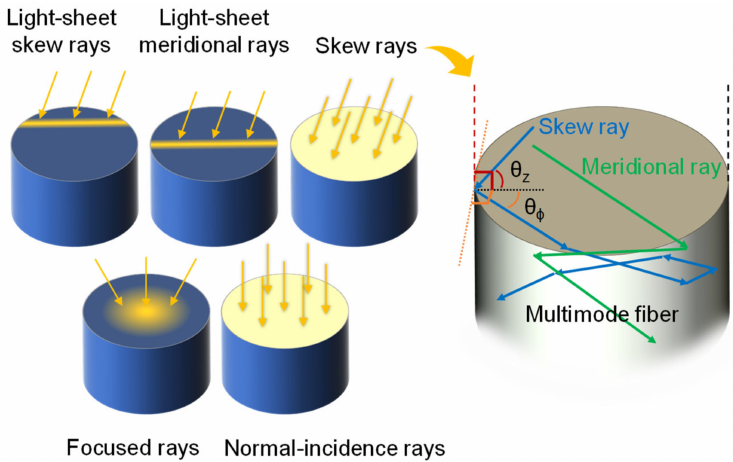
Figure 1. Comparison of di ff erent excitation methods. Inset: propagation behavior for di ff erent ray types.